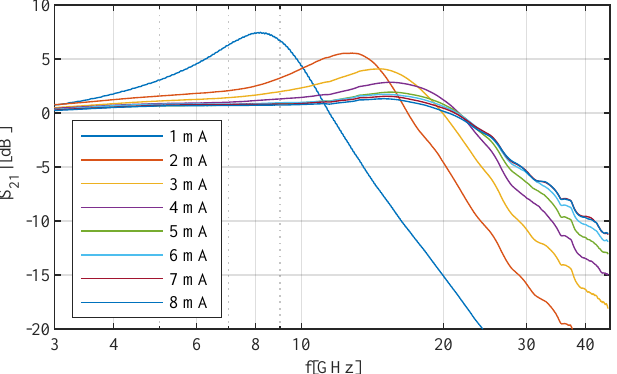
Figure 2. Frequency response of VCSEL for different bias